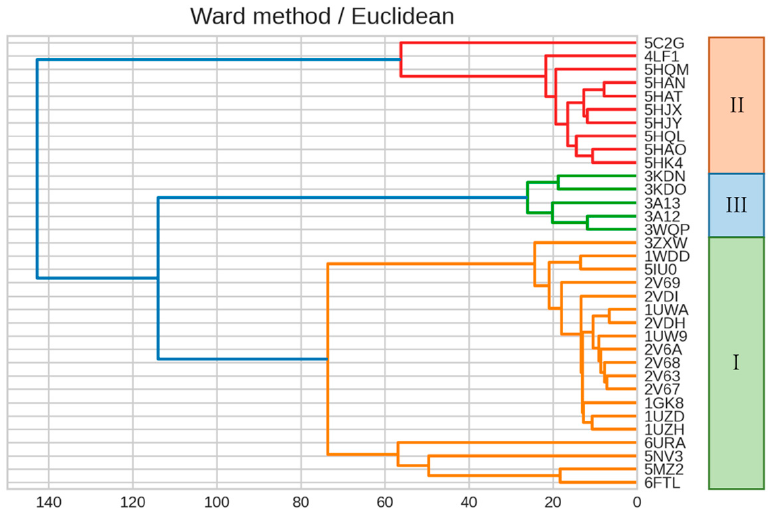
Figure 11. Dendrogram showing the clustering result using Ward’s method, where the dendrogram was created using normalized IFIE data. Color coding is set at 60% of the maximum Euclidean dis- tance.